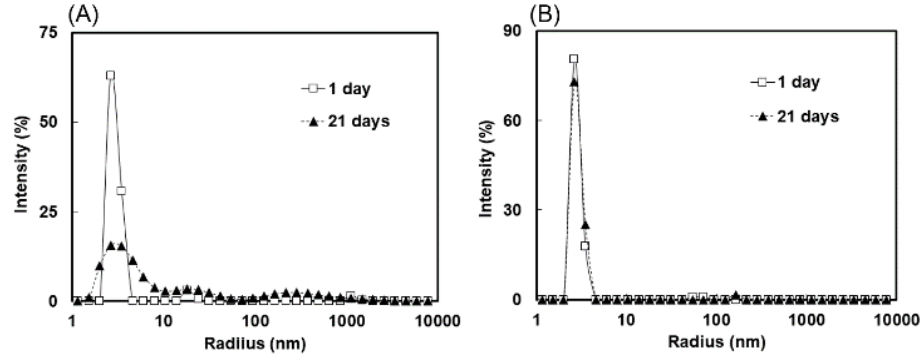
Figure 4. Analysis of molecular size distributions by dynamic light scattering (DLS). Linear 13C7-scFv ( A ) and cyclic 13C7-scFv ( B ) were concentrated to 5 mg/mL, and incubated at 4 °C for 1 day (solid line) or 21 days (dashed line). The DLS measurement was performed at 25 °C.